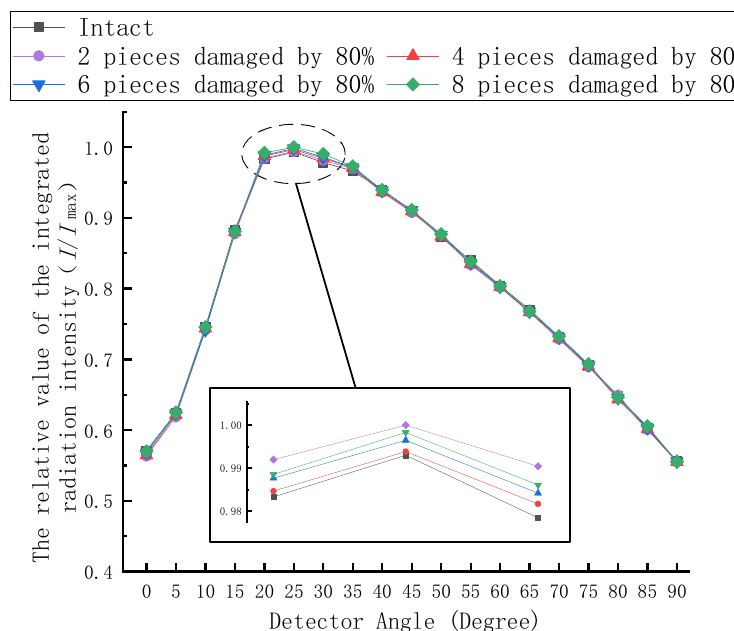
Figure 14. Radiation intensity curves of adjusting plates 1 and 4 of the 3–5 μm band with different damage degrees.